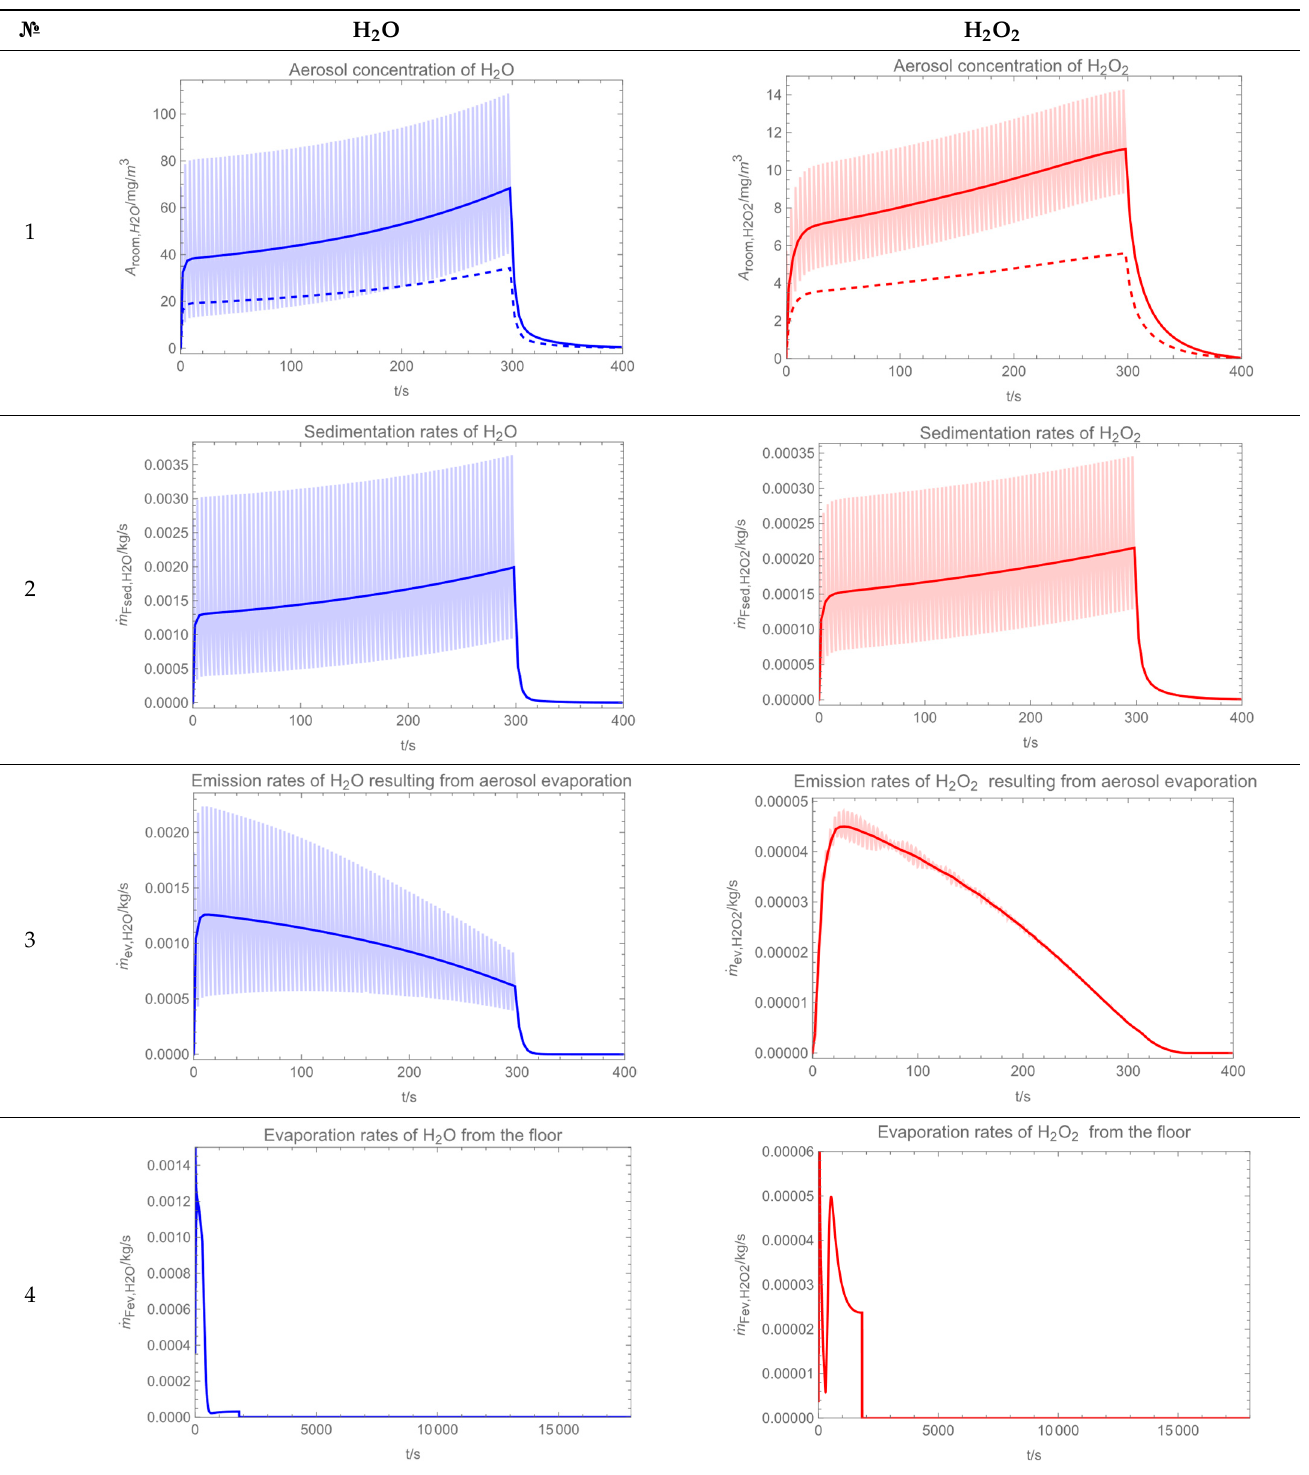
Table 3. Time-dependent modelling results for different parameters of interest.